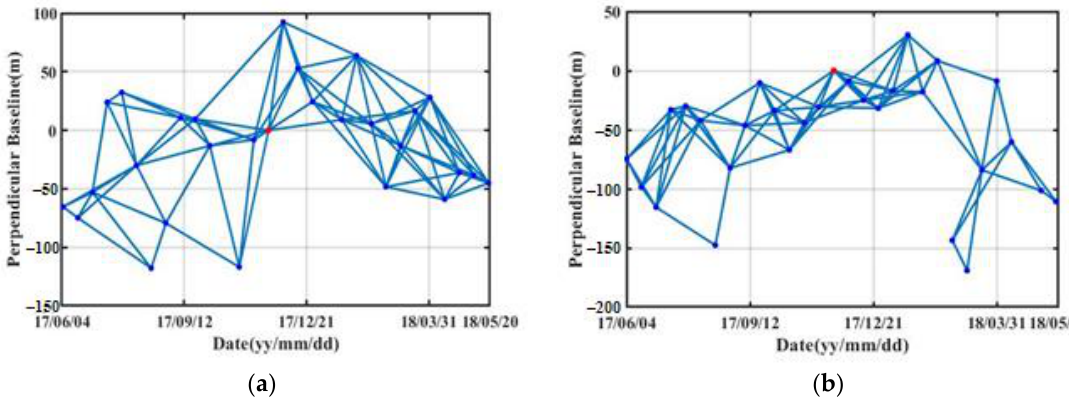
Figure 7. The distribution of spatial and temporal baselines in ascending ( a ) and descending ( b ) orbits. The blue dots and lines represent image acquisitions and interferometric pairs, respectively. The red dots represent the single master image used for co-registration.